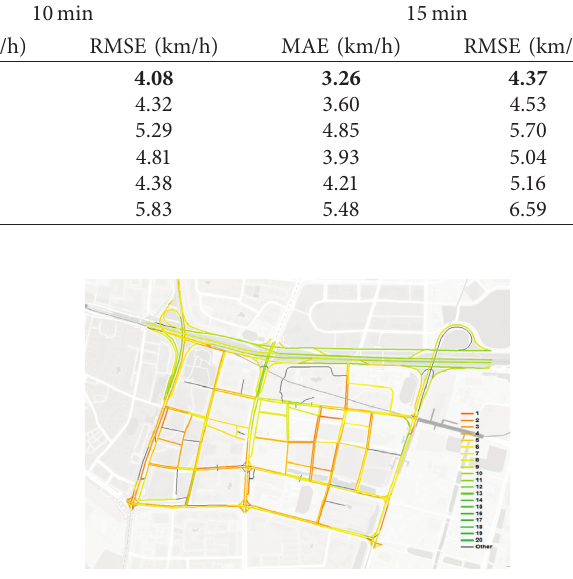
Figure 18: The distribution of real traffic velocity on the road